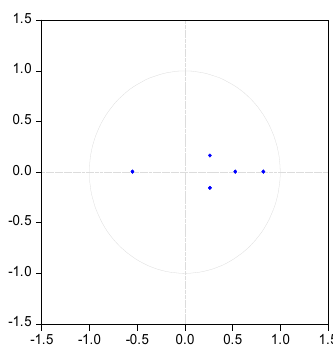
Figure 3. VAR roots of characteristic polynomial of mining and washing of coal. Note: blue dots indicate characteristic roots.